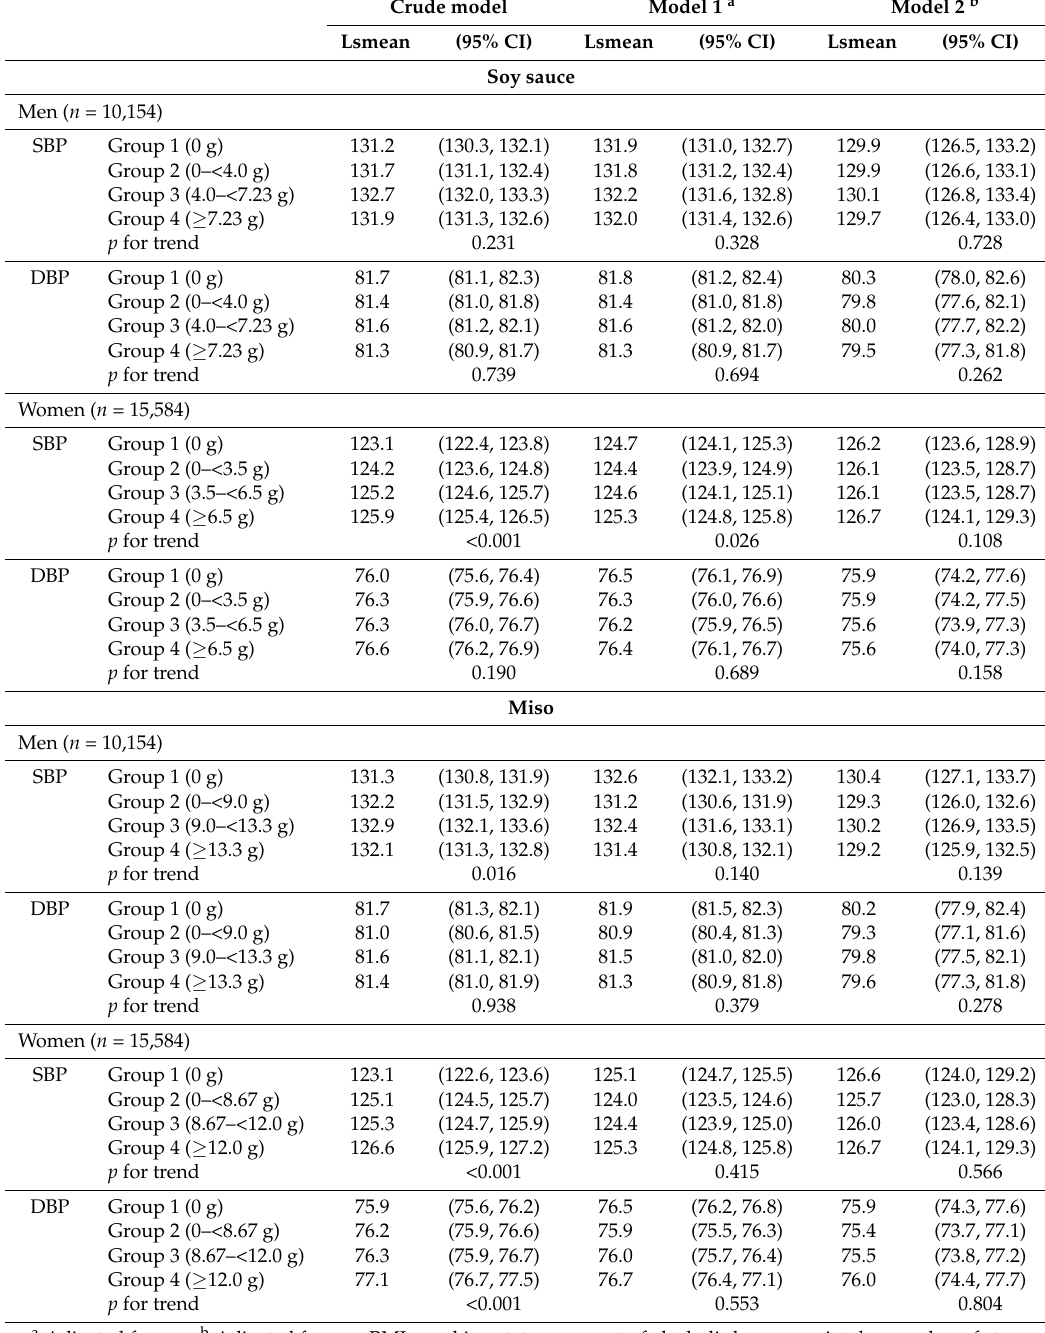
Table 5. Association between the portion sizes of traditional Japanese seasonings and blood